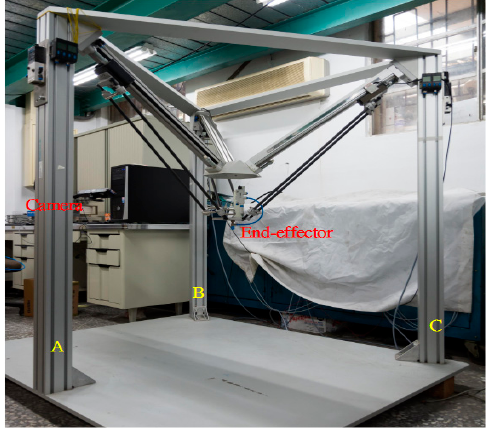
Figure 1. A 3-DOF pneumatic parallel manipulator.